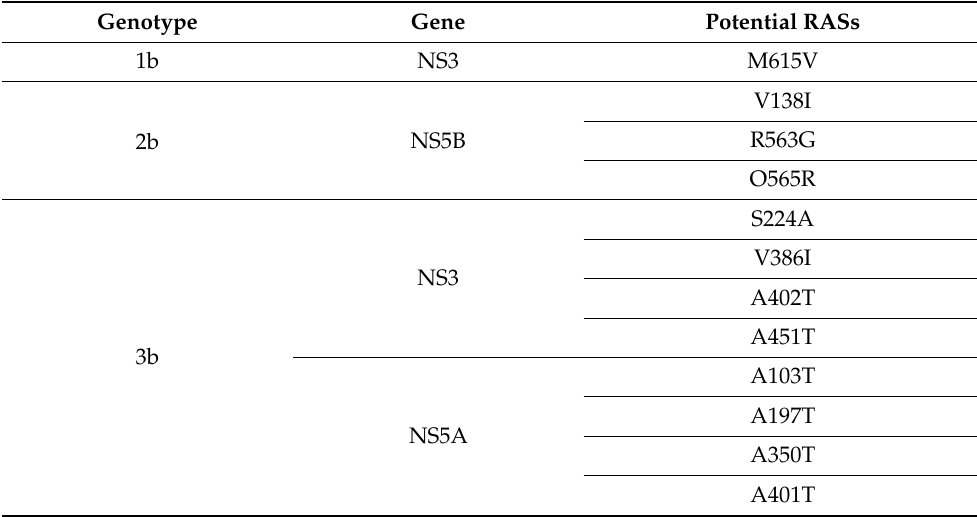
Table 2. Potential RASs identified by whole genome sequencing (WGS).